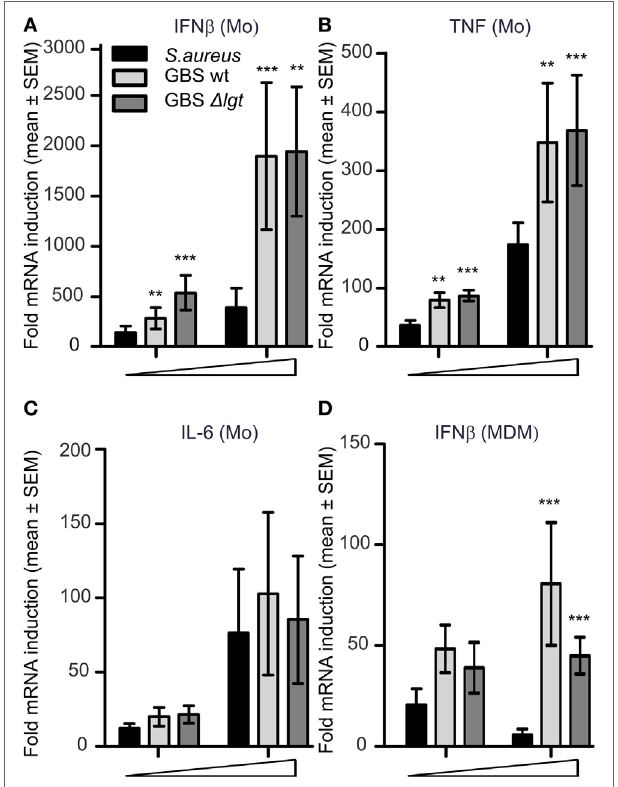
FigUre 2 | Group B Streptococcus (GBS)-induced production of IFN β in monocytes is not dependent on hemolysin and is antagonized by TLR2 ligand. (a) Infection with viable GBS wt, GBS Δ lgt , and GBS hemolysin deficient strains ( Δ cylE Δ cfb ), which is deficient for both the β -hemolysin CylE gene ( cylE ) and the cohemolysin Christie Atkins Munc-Petersen (CAMP) factor gene ( cfb ), and the CylE deficient ( Δ cylE) strain was done for 3 h (MOI 2.0). (a) IFN β and TNF levels in the supernatant determined by ELISA ( n = 4). (B) Cytokine transcript induction determined by quantitative real-time PCR (qPCR) ( n = 6). (c) Infection of monocytes for 18 h with viable GBS wt (MOI 0.02-0.20-2.00) with or without TLR2 ligand FSL-1 (100 ng/ml) costimulation. Levels of IFN β in the supernatants were determined with ELISA ( n = 4), while IL-12-p70 levels were determined by bioplex ( n = 3). In non-infected samples the levels were below the limit of detection (1 pg/ml for IFN β and 20 pg/ml for